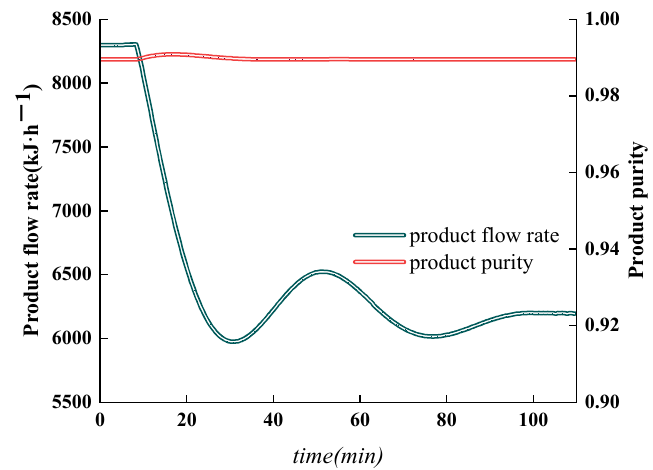
Figure 13. Process 1 (cid:13) product curve after PID parameters were Figure 13. Process ① product curve after PID parameters were adjusted.